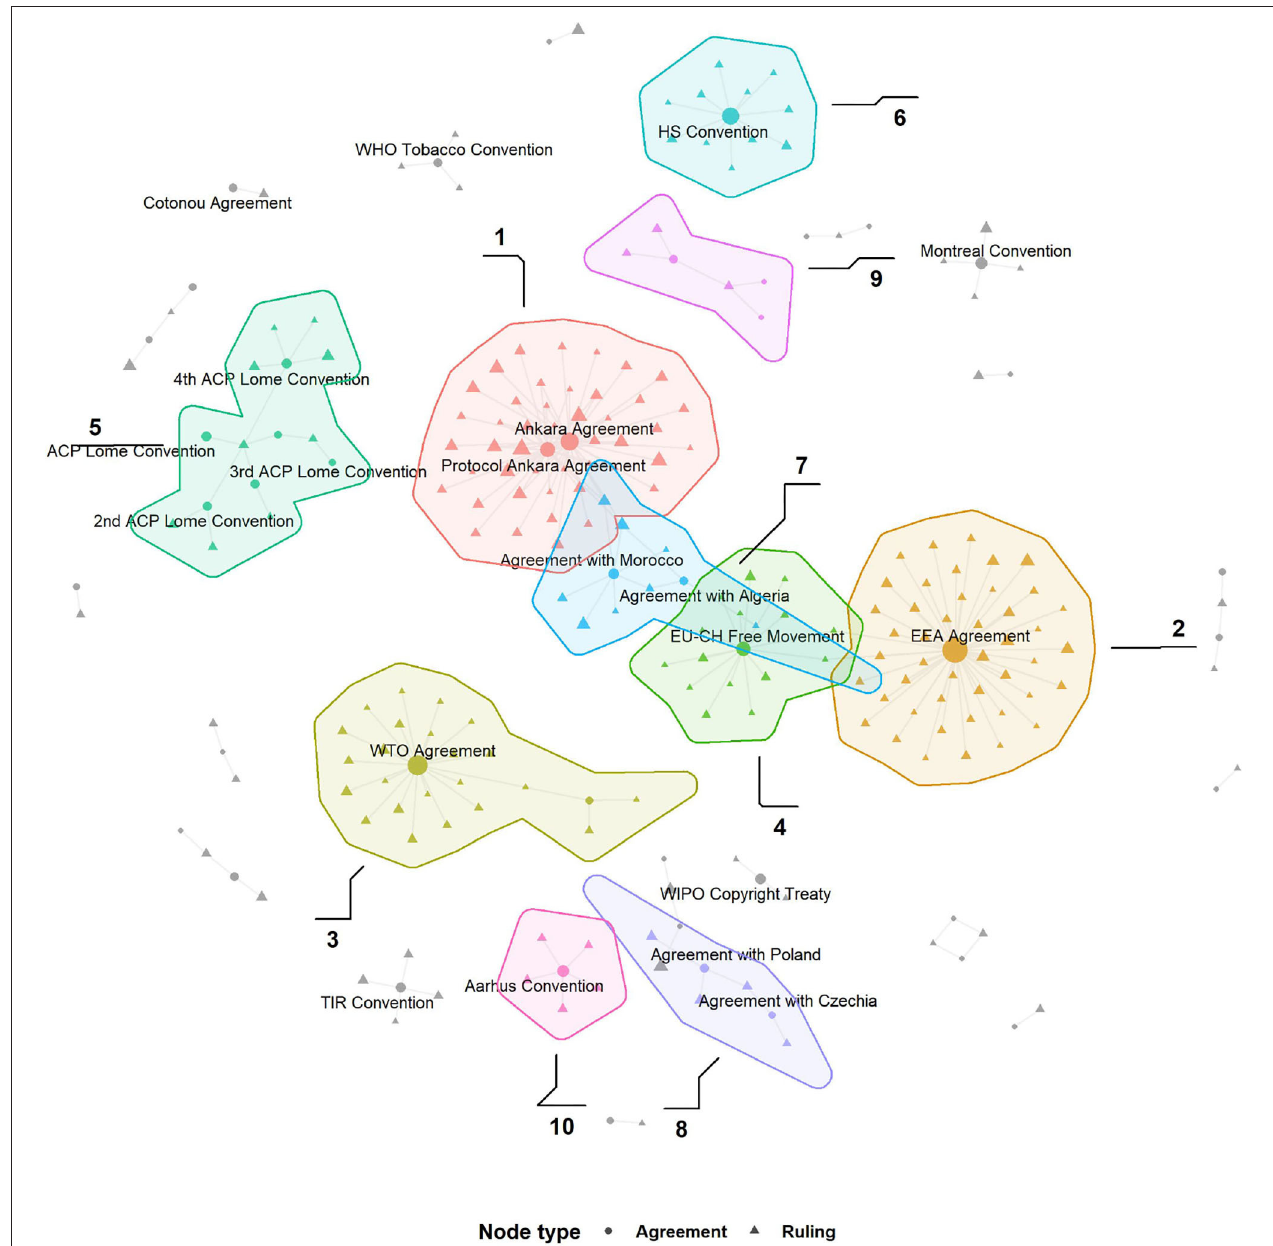
FIGURE 4 | Most prominent EU international agreements in the case law of the European Court of Justice. Network is restricted to direct citations to international agreements. Node size for international agreements reflects in-degree centrality. The more edges point toward a node, the larger its size. Colored areas, labeled from 1 to 10, represent network communities identified via Newman’s [24] fast-greedy algorithm.